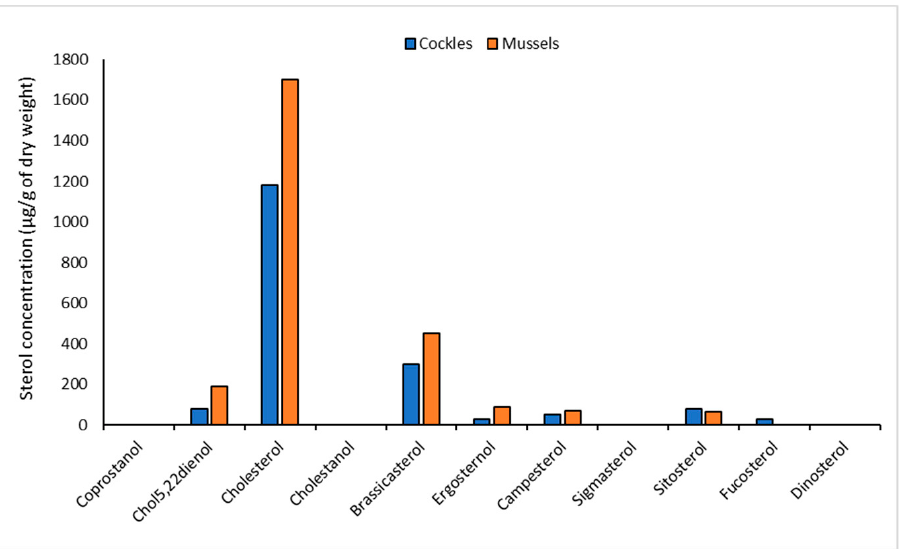
Figure 5. Sterol concentrations ( µ g g − 1 dry weight flesh) determined in cockles extracted from Freshers Creek and mussels extract from Simpoles